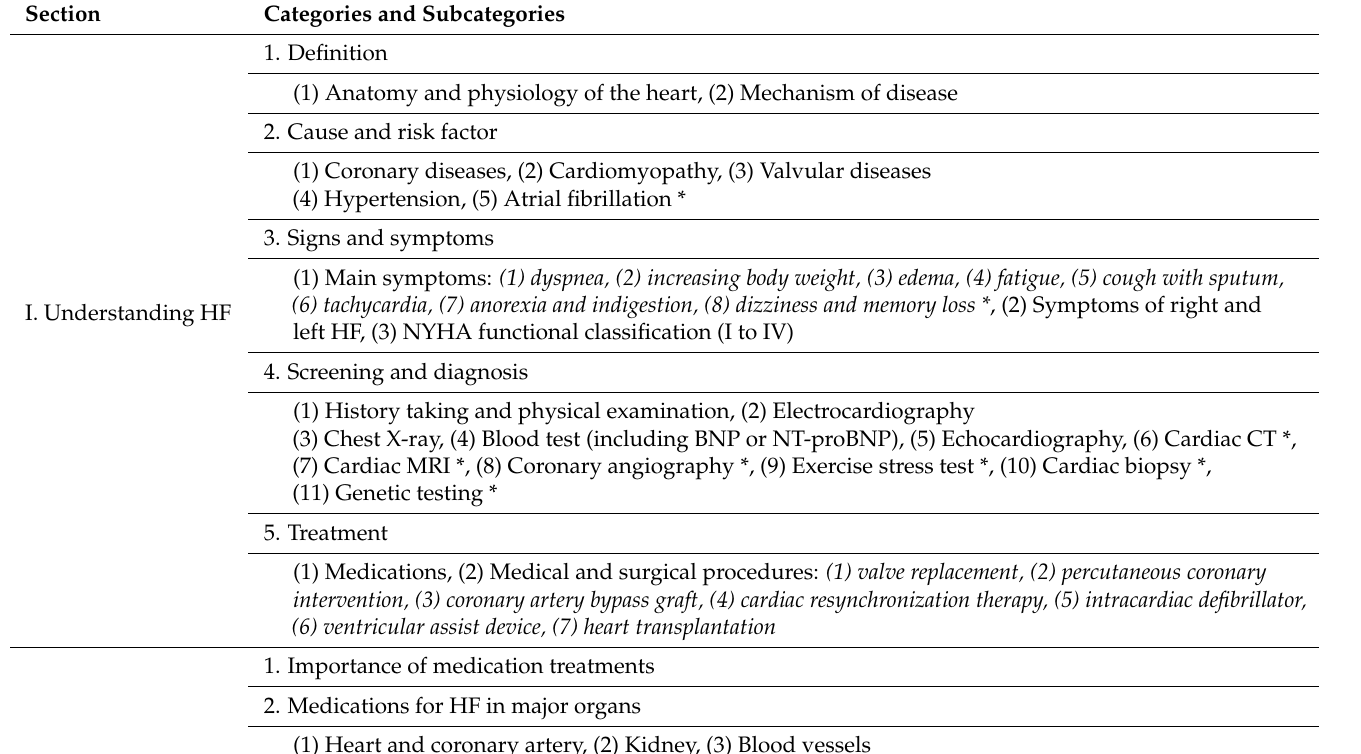
Table 1. Final content of heart failure discharge education after the first